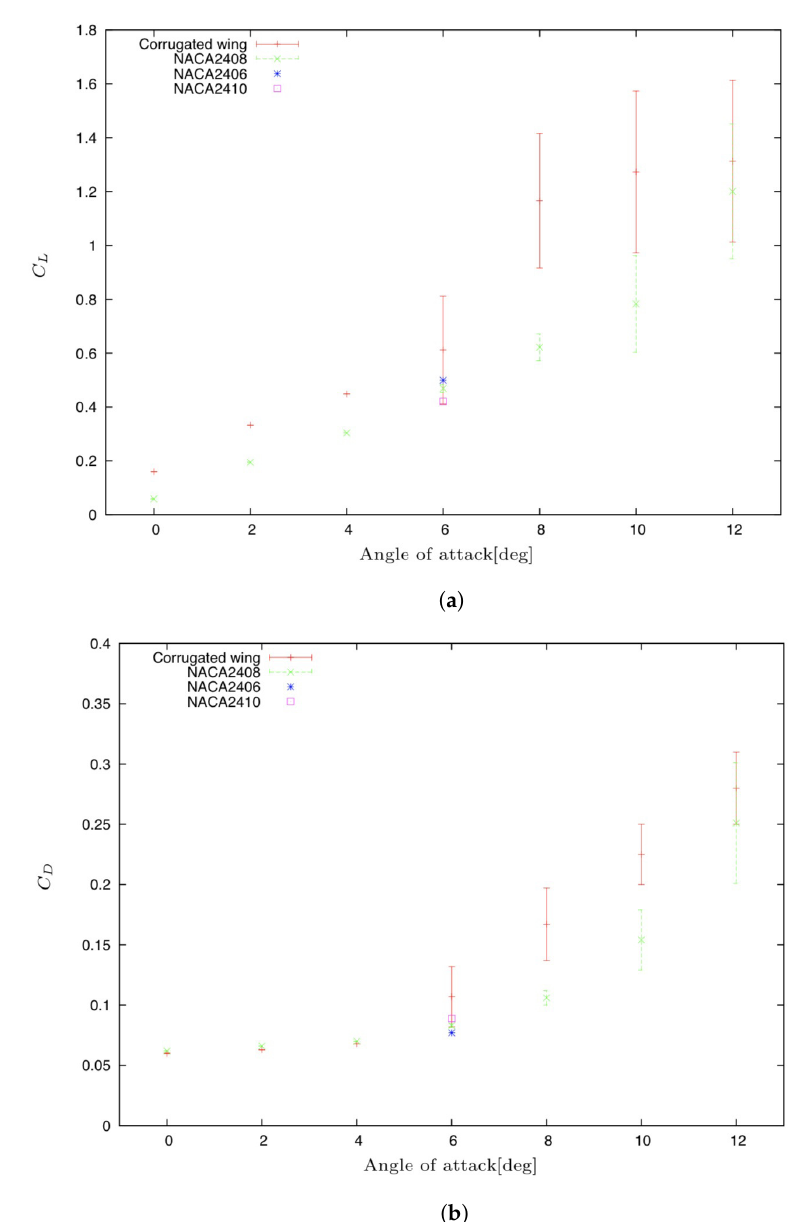
Figure 11. The mean lift and drag coefficient of the two dimensional corrugated airfoil and the profiled NACA airfoil at Re = 4000 with varying angle of attack: ( a ) lift coefficient; and ( b ) drag